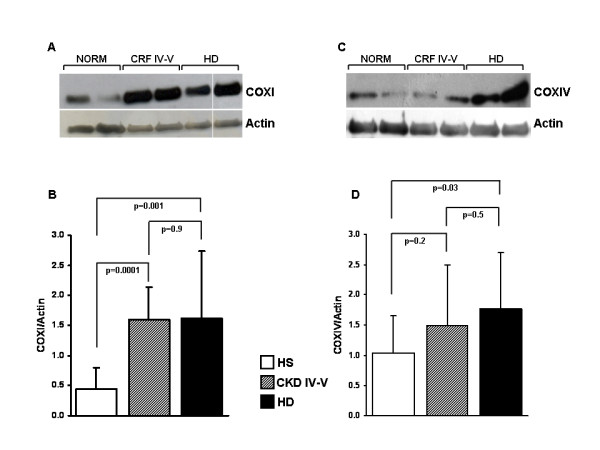
COXI (A and B) and COXIV (C and D) protein expression in peripheral blood mononuclear cells (PBMC) from healthy subjects (HS), chronic kidney disease (CKD IV–V) and hemodialysis (HD) patients. Panel A and C show a representative western blotting experiment respectively for COXI and COXIV. The histograms represent the mean ± SD of COXI (panel B) and COXIV (panel D) protein levels in total cell lysate of 12 HS, 10 CKD IV–V and 14 HD patients assessed by Western blotting. COXI and COXIV protein level was significantly higher in HD and CKD compared to HS.